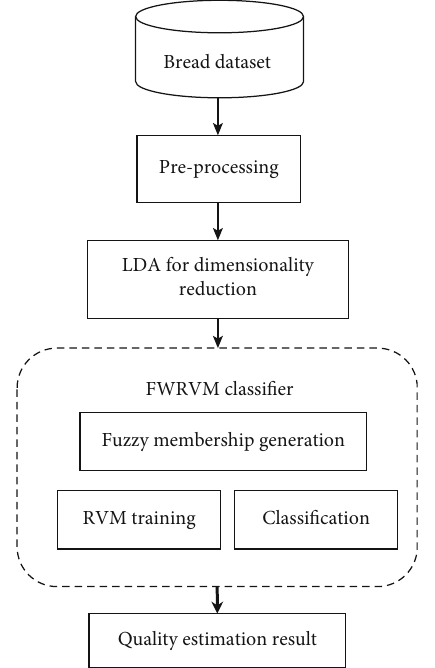
Figure 1: Proposed Bread Quality estimation